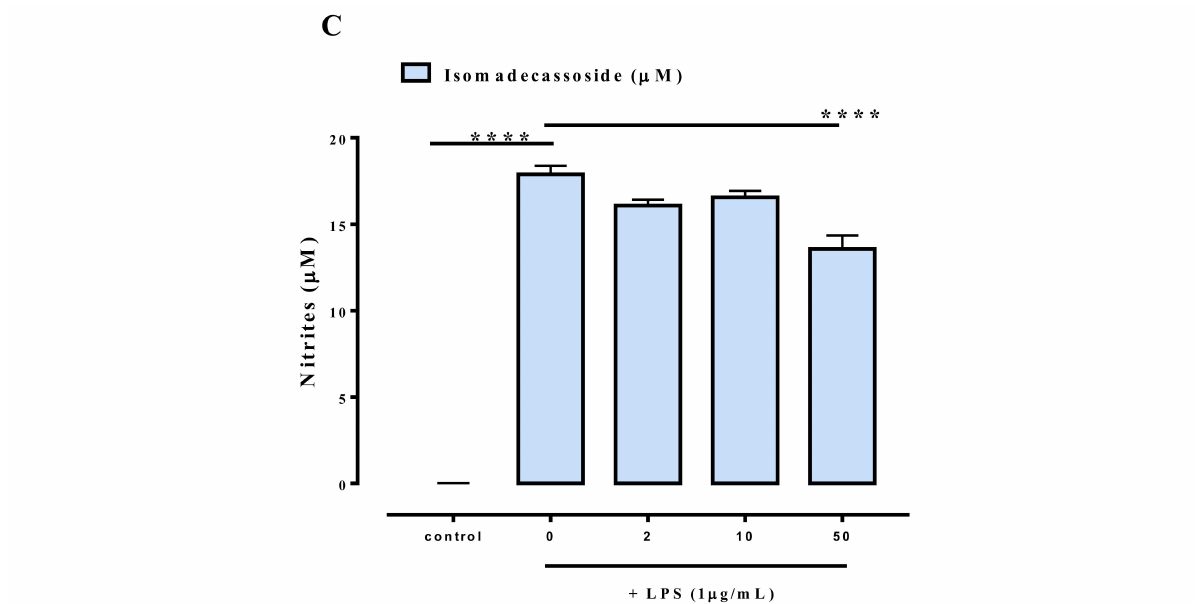
Figure 4. Inhibitory effect of madecassoside ( A ), terminoloside ( B ) and isomadecassoside ( C ) on nitrite levels in the cell medium of J774A.1 macrophages stimulated with lipopolysaccharide (LPS, 1 µ g/mL) for 24 h. The compounds were added to the cell media 30 min before LPS stimulus. Results are expressed as mean ± SEM of four independent experiments (in quadruplicate). * p < 0.05, ** p < 0.01, *** p < 0.001 and **** p <